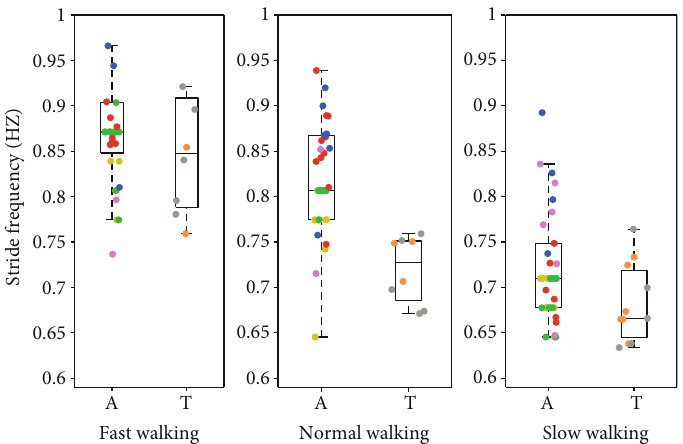
Figure 16: Stride frequency of participants with intact limbs and prosthesis users at three speeds with the normal speed being their preferred speed. The data from participants with intact limbs is shown on the left (A) and transfemoral prosthesis user data is shown on the right (T) in each pair. The fi gure shows the median, along with a box that bounds the fi rst and third quartiles of the data, and whiskers that bound the entire range of the data (apart from outliers). Moreover, the scatter plot shows the average stride frequency of each trial. The data for each subject are color-coded: yellow = AB01 , green = AB02 , red = AB03 , blue = AB04 , purple = AB05 , brown = PR01 , and gray = PR02